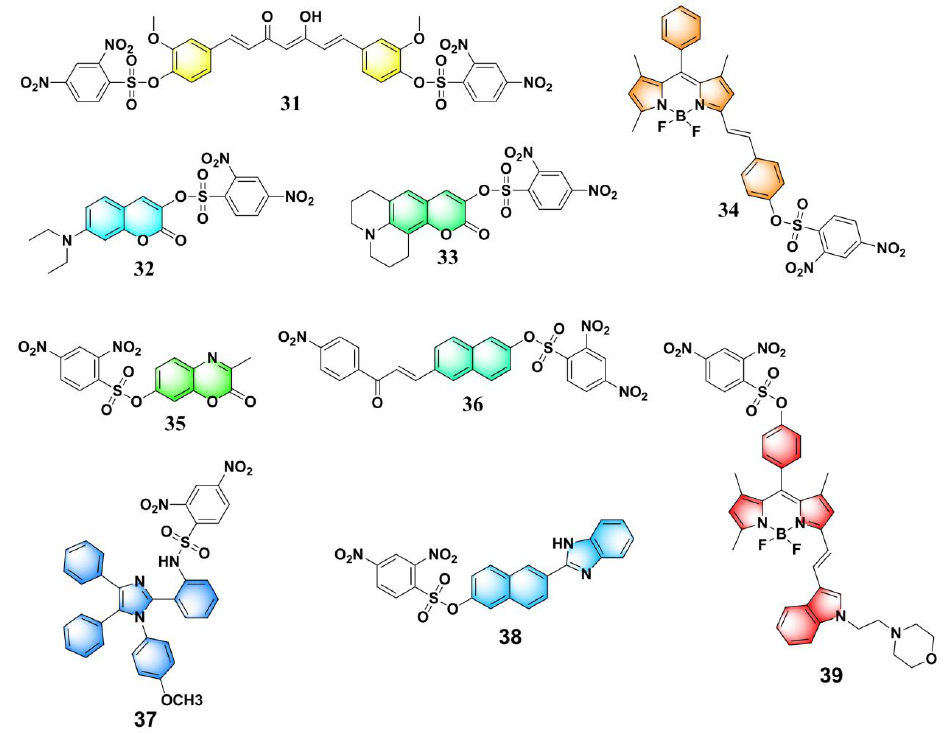
Figure 15. Fluorescent PhSH probes based on the recognition unit of